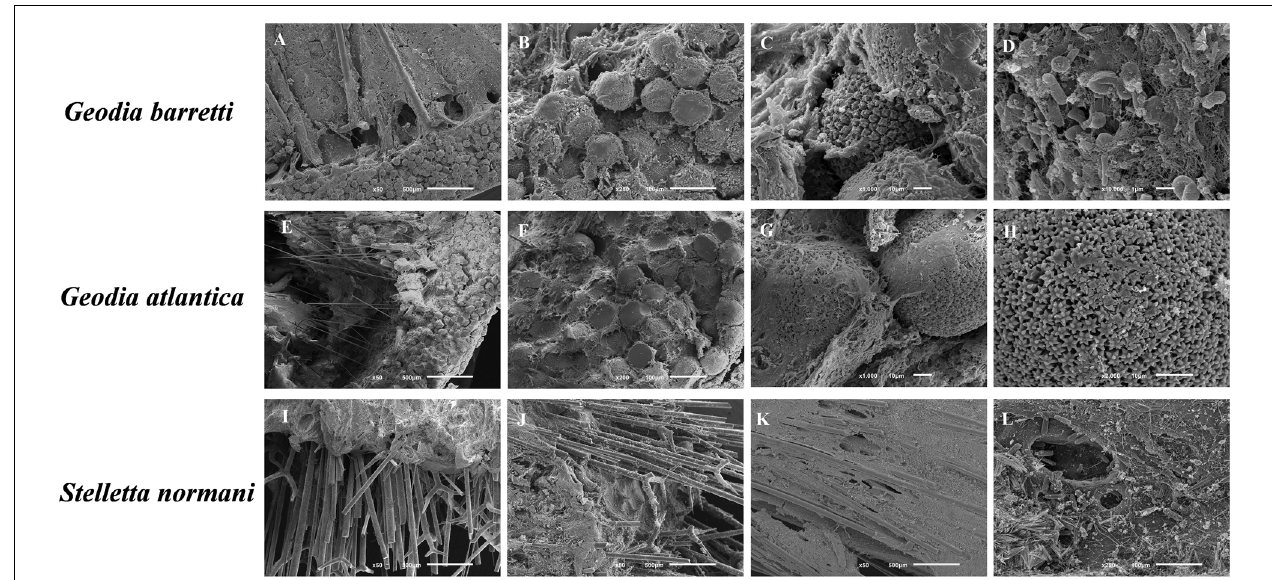
FIGURE 4 | SEM micrographs of the morphological elements and architecture of the massive to (sub)spherical sponge species, namely G. barretti (A–D) , G. atlantica (E–H) , and S. normani (I–L) . (A) Cross-section showing the cortex with a layer microscleres (sterrasters), supported by radially arranged megascleres (dichotriaenes). (B) Sterrasters embedded in an organic matrix. (C) Detail of a sterraster embedded in an organic matrix. (D) Cellular and fibrillar organic elements present in the sponge’s mesohyl. (E) Cross-section showing the cortex with a layer microscleres (sterrasters), supported by radially arranged megascleres (orthotriaenes and oxeas). (F) Detail of the cortical layer of sterrasters. (G) Two sterrasters embedded in an organic matrix. (H) Detailed view of the surface of a sterraster showing its rosettes with smooth rays. (I) Cross-section showing megascleres (pro/dichotriaenes and oxeas) protruding the ectosome. (J) Trianes spicules (K) Radial skeleton arrangement embedded in an organic matrix. (L) Choanosome with a rich organic matrix and embedded microscleres